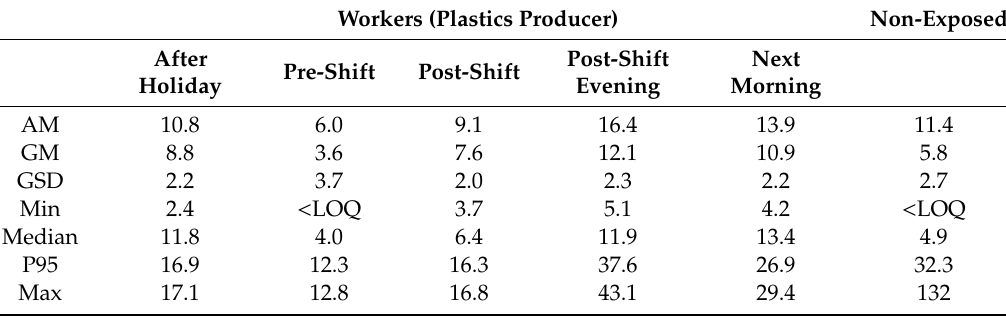
Table 3. Total urinary monocarboxy isooctyl phthalate (cx-MiOP) concentrations of workers in plastics producing company ( n = 5) by sampling time. First-morning-void concentrations of occupationally non-exposed control population ( n = 60) are provided for comparison [9]. Concentrations ( µ g / L) were normalized to a specific gravity of 1.021. Workers (Plastics